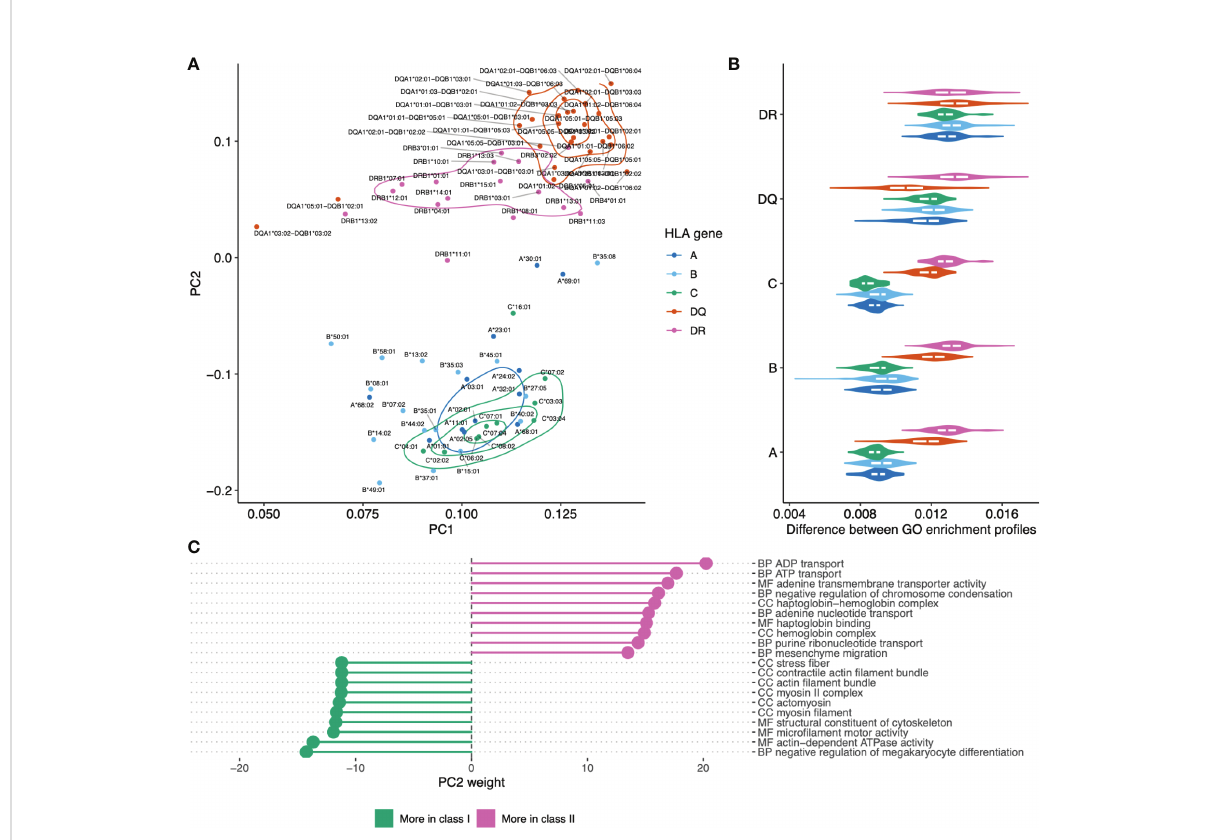
FIGURE 5 Visualizing similarities between HLA alleles based on enriched GO categories of genes they tend to present. (A) Principal component analysis (PCA) results for GO category fold enrichment pro fi les of various HLAs. GO enrichment pro fi les are computed based on gene sets obtained by mapping HLA ligands from the HLA ligand atlas dataset as the logarithm of observed to expected fraction of genes representing a given GO category. Color shows HLA gene: A/B/C for class I and DR/DQ for class II. (B) Distribution of pairwise distances between GO enrichment pro fi les of HLA alleles of the same and distinct HLA genes. Y axis corresponds to the HLA gene of the fi rst HLA allele in each pair, the gene of the second allele indicated by color (same as in A ). Euclidean distance divided by the total number of GO categories is used. ( С ) List of the top 10 GO categories that have most absolute weight in PC2 (see panel A ). Negative weight corresponds to dominance in class I HLA alleles, while positive weight corresponds to dominance in HLA class II. GO term names are preceded by either CC (cellular component), MF (molecular function) or BP (biological process) ontology